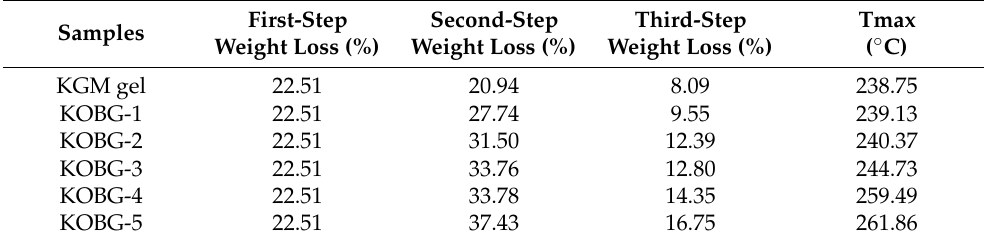
Table 1. The TGA parameters of the KGM gel and the composite